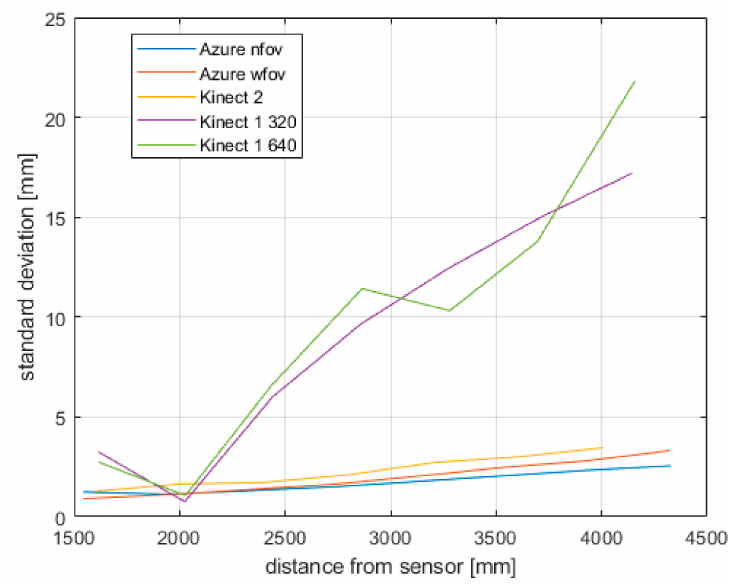
Figure 4. General precision measurements of all three Kinect